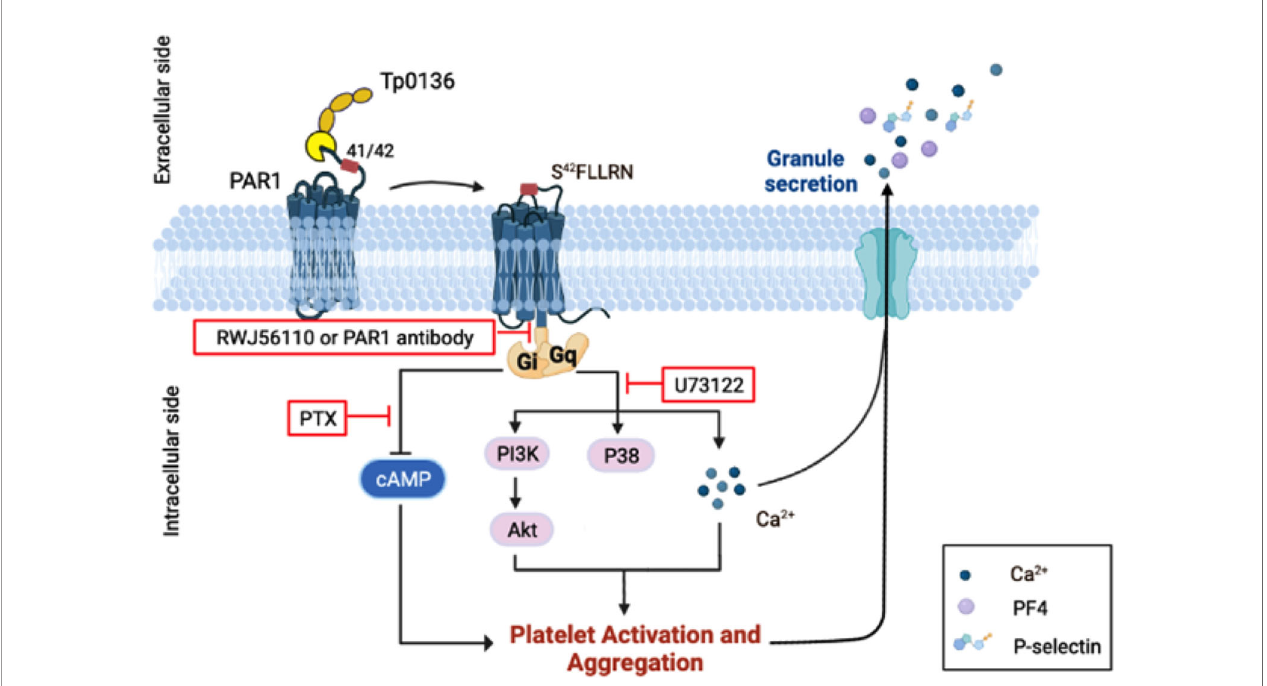
FIGURE 6 | Schematic model of the mechanism by which Tp0136 modulates platelet signaling. Tp0136 promotes human platelet activation and aggregation through PAR1 and generates an S 42 FLLRN-tethered ligand that interacts with the receptor to induce PAR1 signaling. In particular, Tp0136 activates the G q signaling pathway through PAR1, thereby inducing PAR1-dependent Akt-PI3K activation, p38 phosphorylation and Ca 2+ fl ux, and the G i pathway, thereby attenuating the release of cytosolic